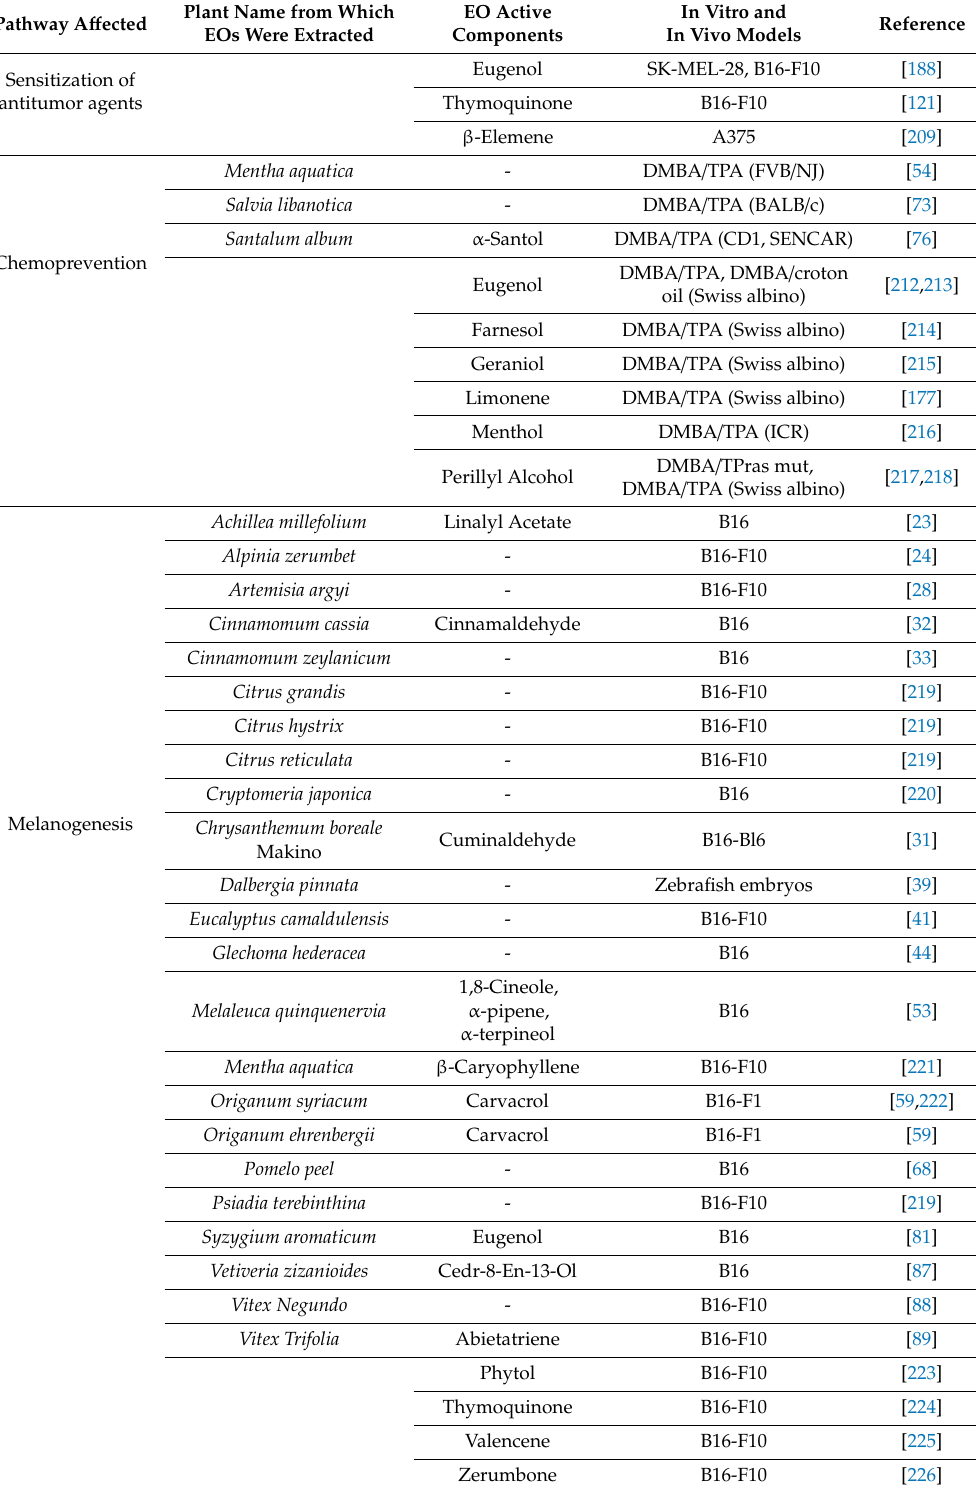
Table 5. E ff ect of EOs and their components in the sensitization of antitumor agents, chemoprevention and